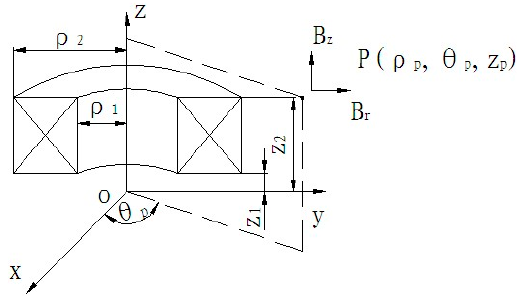
Figure 3. Model for computing the field strength.